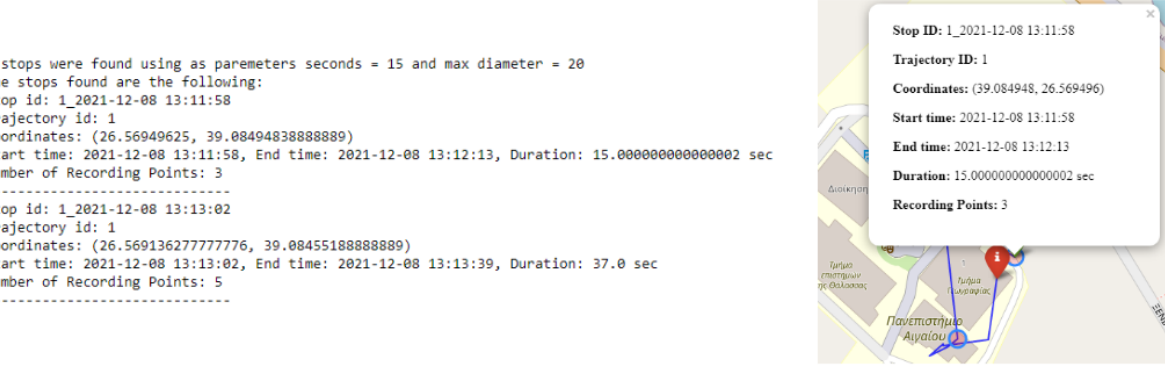
( b ) Figure 14. Interactive visualization of a trajectory. ( a ) Visualization of information contained in each point of the trajectory; ( b ) visualization of the data contained in a stop area of the trajectory.